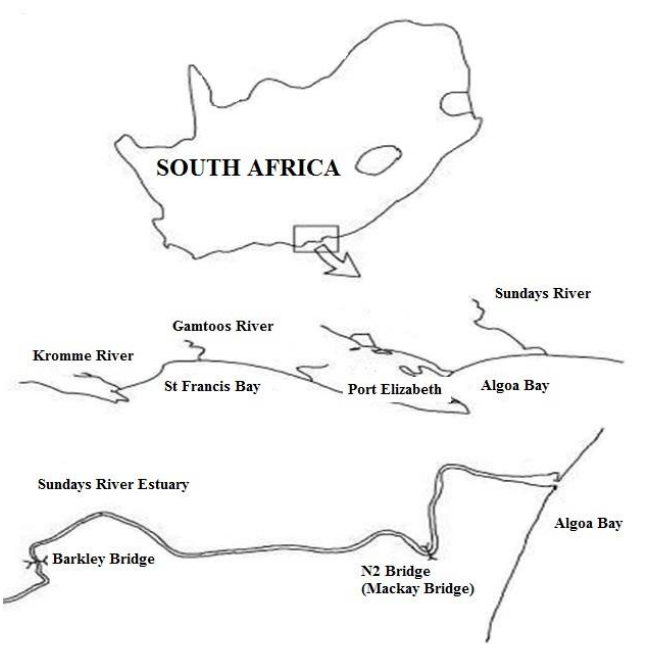
FIGURE 1: The Sundays River Estuary